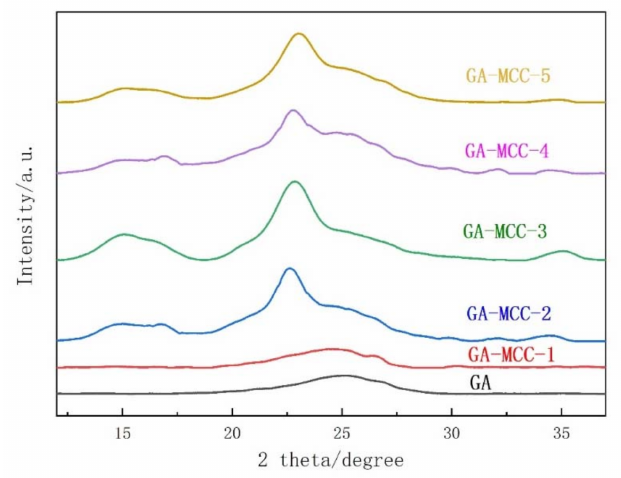
Figure 4. XRD of GA aerogel and GA-MCC (1–5)